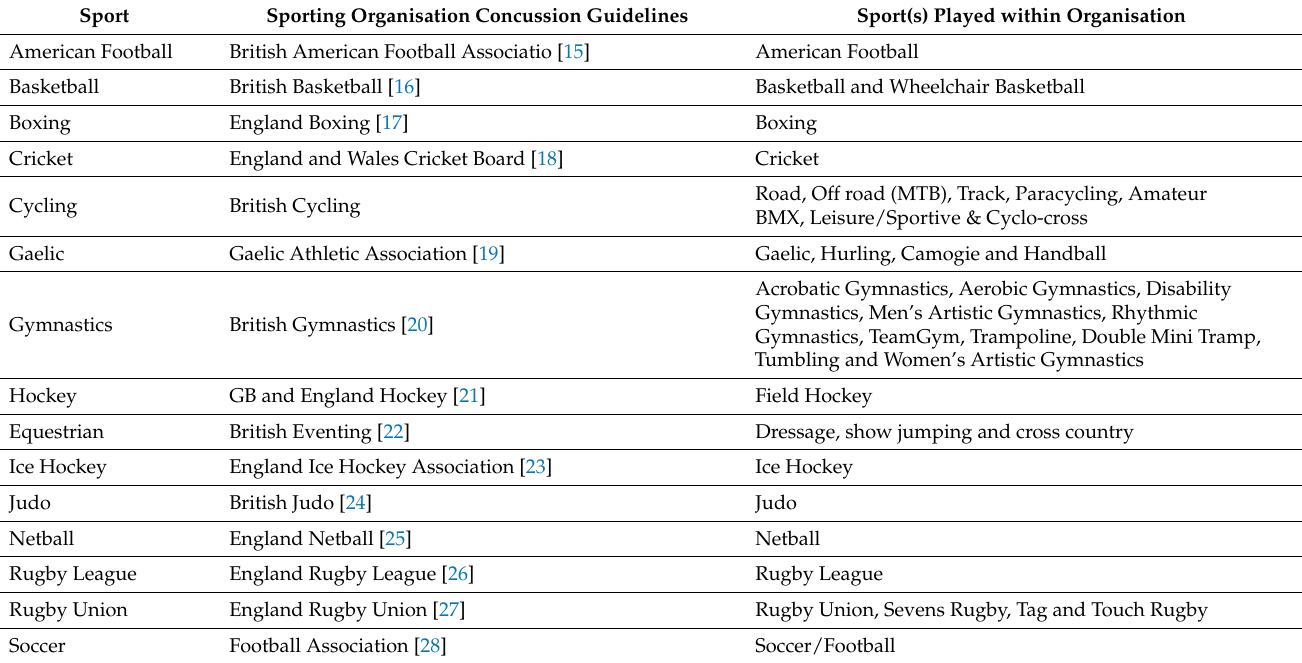
Table 1. British sporting organisations under